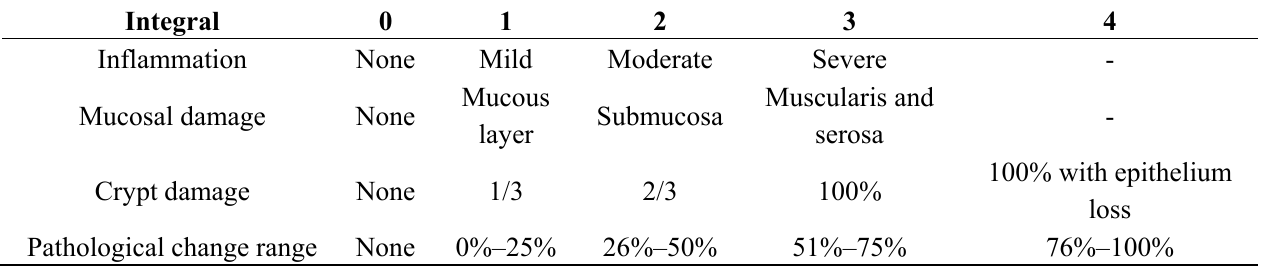
Table 3. Histology injury score